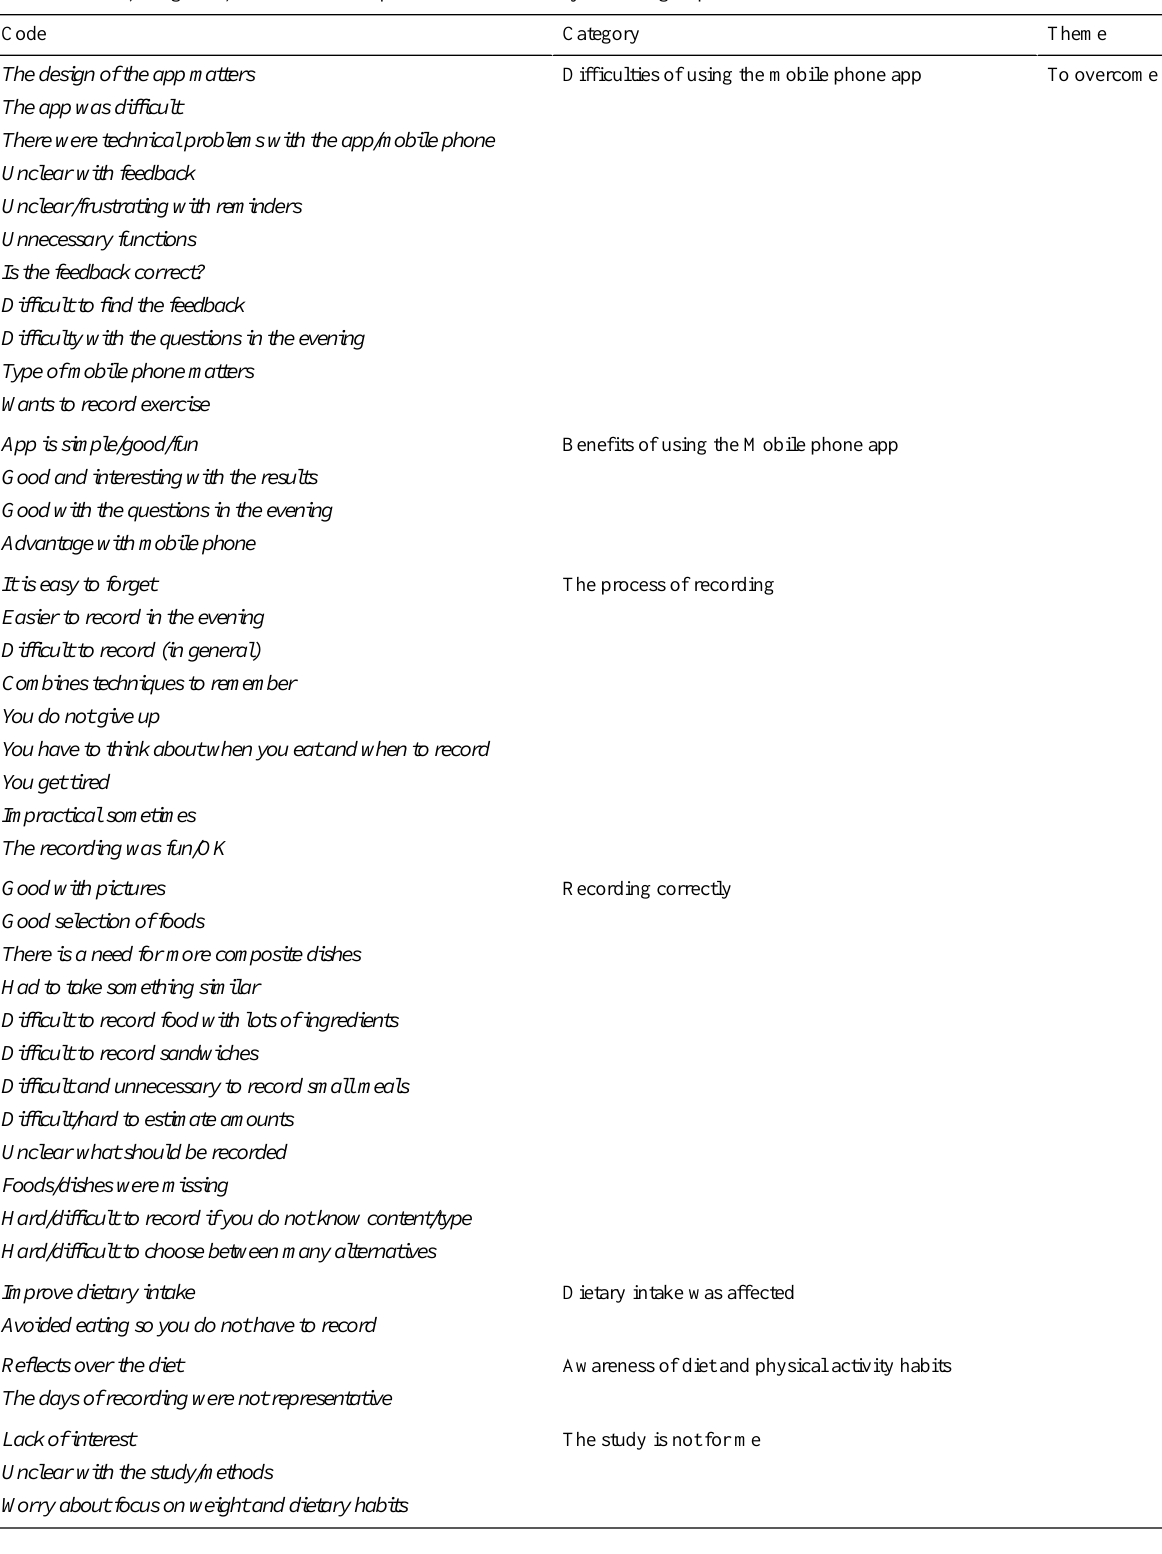
Table 2. Codes, categories, and theme from qualitative content analysis of 12 group interviews.